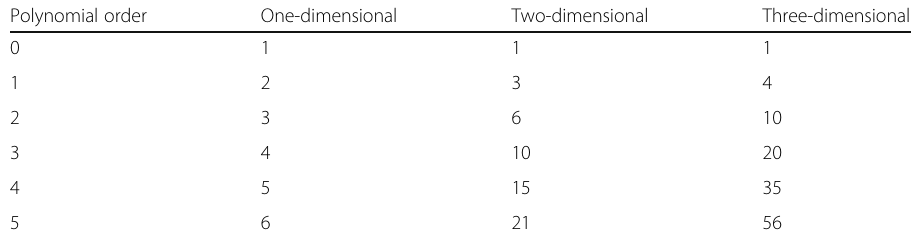
Table 1 Number of basis functions required for the computational element with accuracy up to 5th order